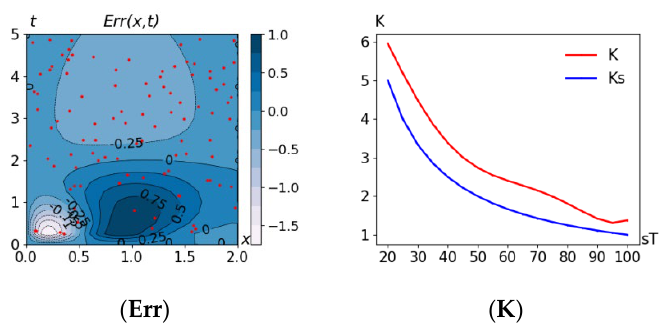
Figure 9. SvF solution of Problem 5.6: ( Err ) Err(x,t) = T(x,t)-Ts(x,t) ; ( K ) the thermal conductivity co- efficient.